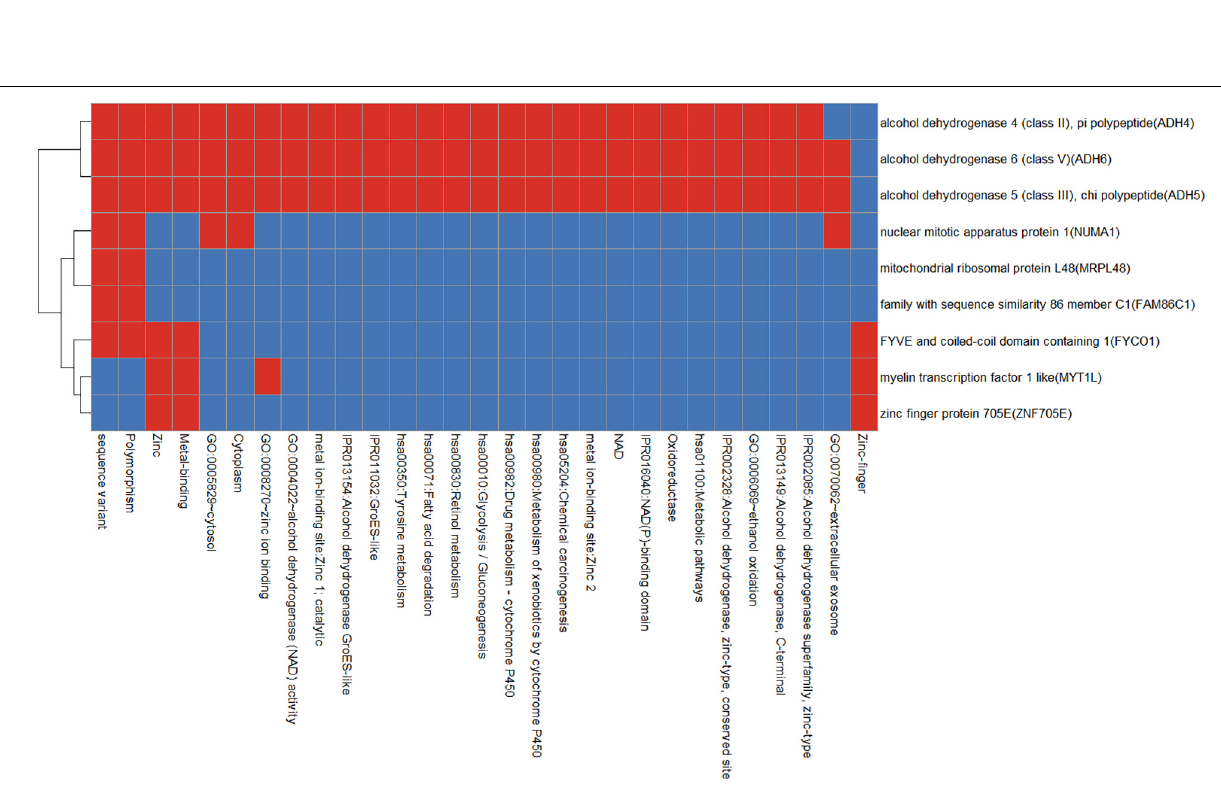
Frontiers in Cell and Developmental Biology |